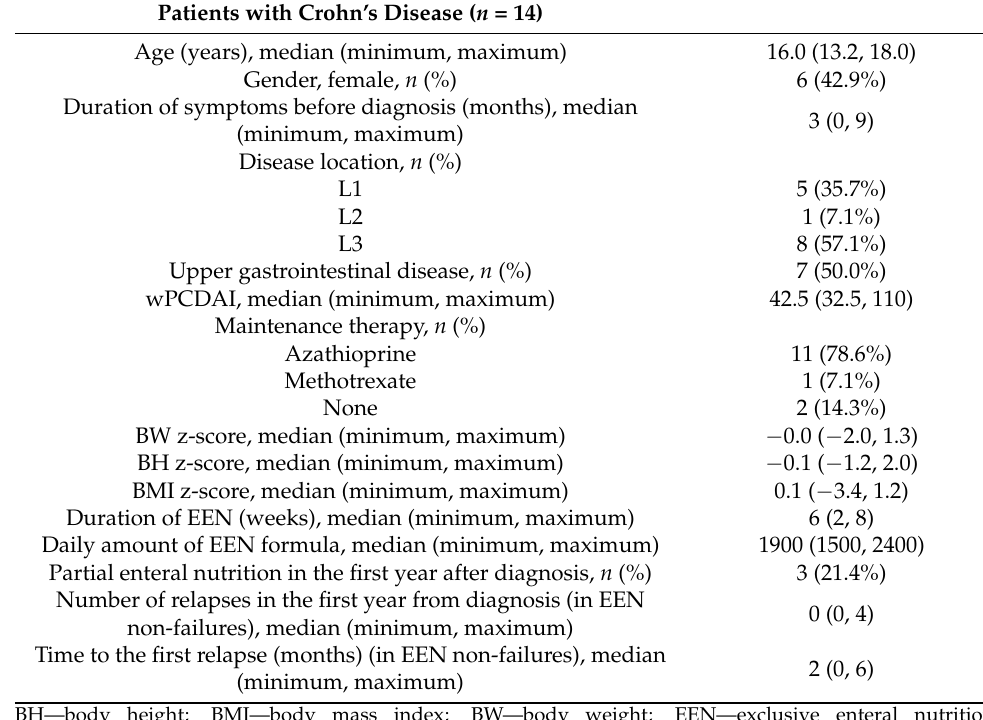
Table 1. Demographic data of patients with Crohn’s disease at diagnosis ( n = 14). Patients with Crohn’s Disease ( n =